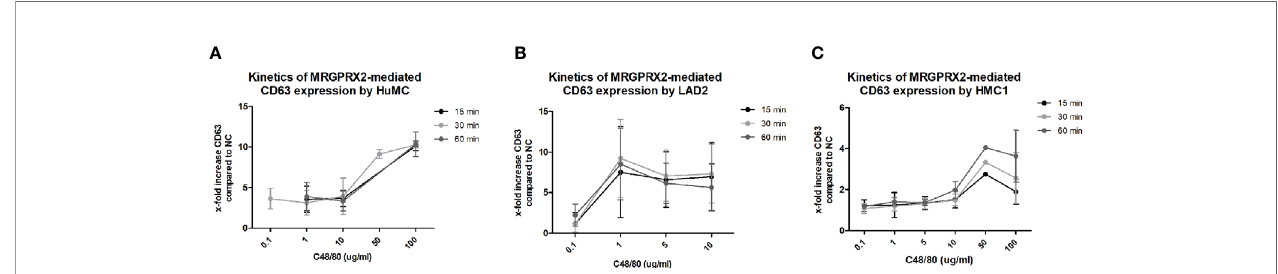
FIGURE 6 | Different kinetics of MRGPRX2 mediated degranulation of three mast cell lines: HMC1, LAD2, HuMC. The mean x-fold increase of CD63 expression upon stimulation with C48/80 is shown for all three cell lines at different concentrations of C48/80 and different time periods of stimulation. The error bars depict SEM. n=2 for HuMC and LAD2s and n=3 for HMC1s. (A) HuMCs of two donors were used. Both showed a similar pattern, with signi fi cant CD63 upregulation only for the highest concentrations of C48/80. There was no difference for different periods of stimulation. (B) LAD2s responded to much lower concentrations of C48/80, and 30 minutes proved the optimal period of stimulation. However, considerable variation was seen between the experiments. (C) HMC1s, pre-incubated with Lat-B, only showed CD63 upregulation upon stimulation with C48/80 at a concentration of 50 or 100 µg/ml for